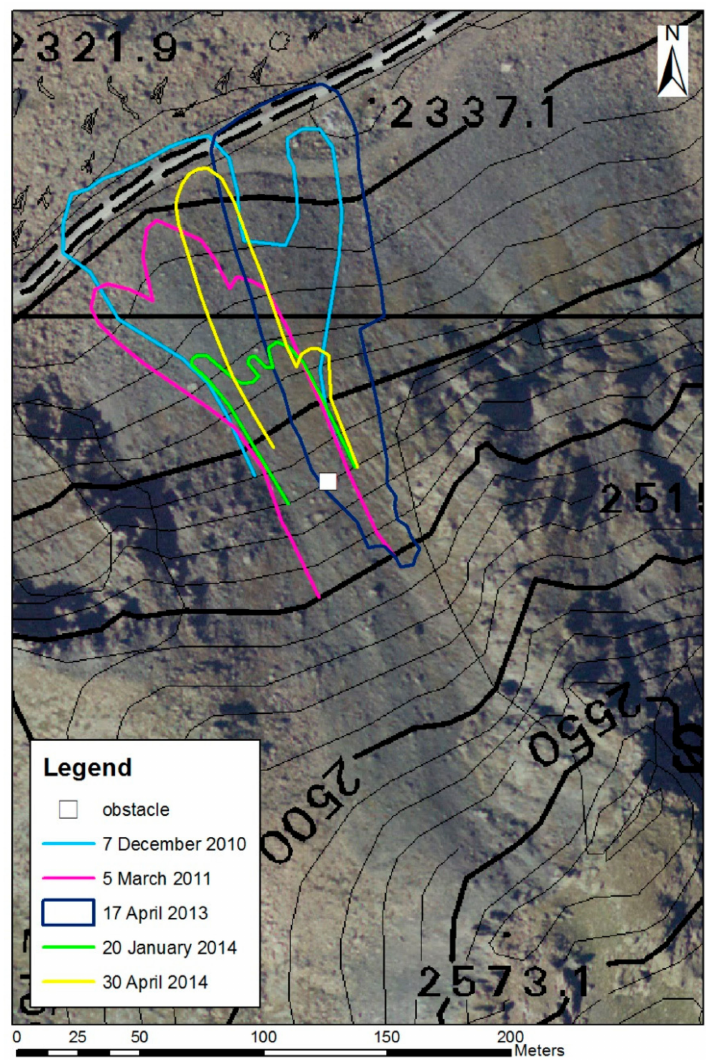
Figure 2. Outlines of the five selected avalanches in the track and deposition zones. Only for the 17 April 2013 event could we also determine the release zone well, and therefore the blue polygon shows the overall avalanche